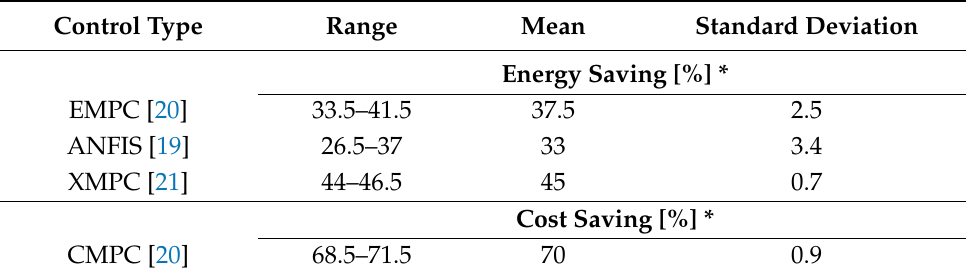
Figure 21. Monte-Carlo simulation results of the combined MicroCSP and building HVAC system showing the probability of: ( a ) the energy savings when EMPC is applied; and ( b ) the electricity cost savings when CMPC is applied. The reported numbers are by comparing to when RBC is applied. (Reprinted from [20] with permission of Elsevier). Table 5. Summary of the Monte-Carlo simulation results of the different control frameworks by considering prediction